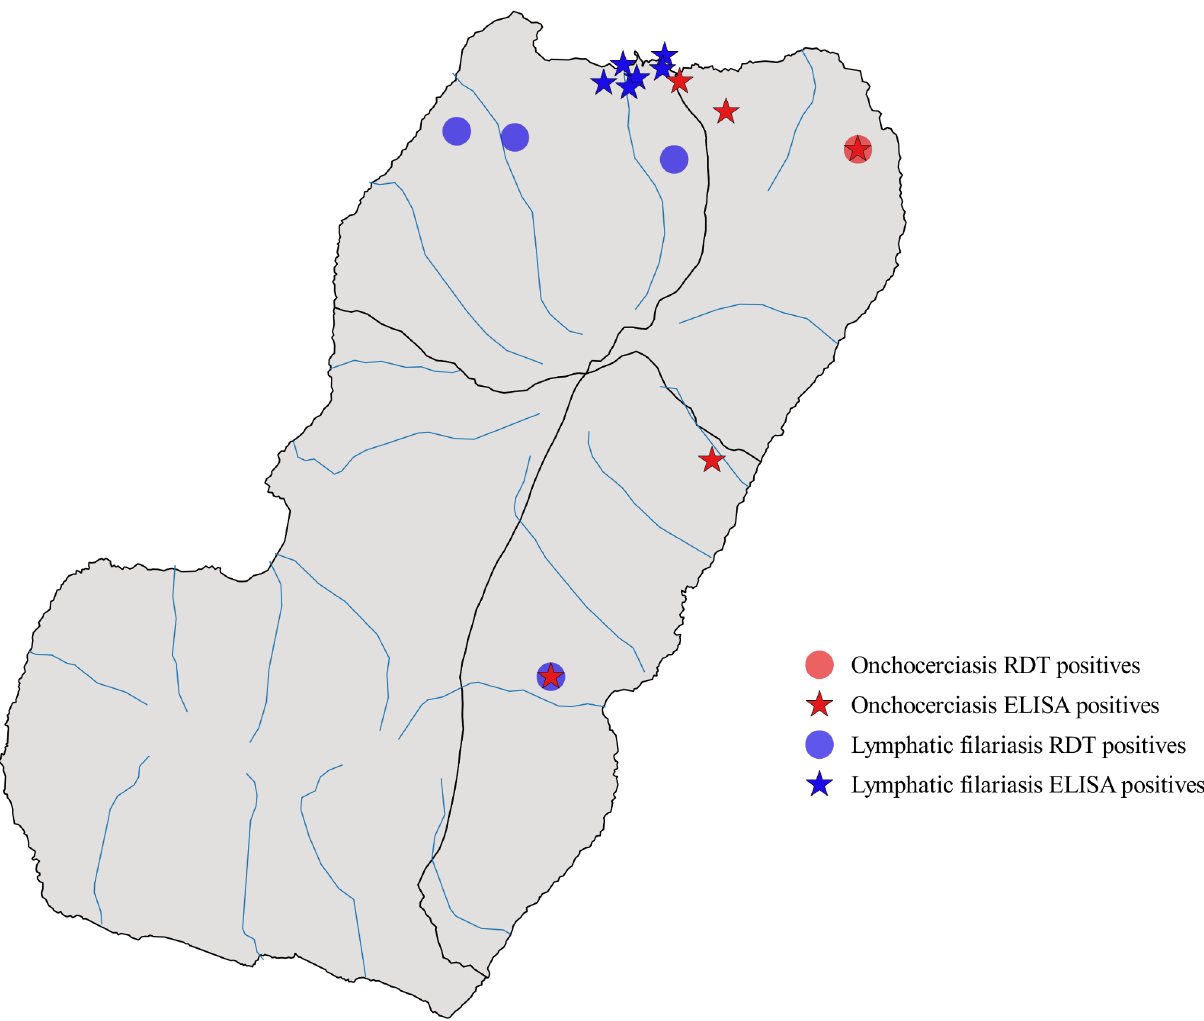
Fig 2. Geographical distribution of RDT and ELISA positives in 5- to 9-year-old school children in Bioko Island, September 2016 to January 2017.